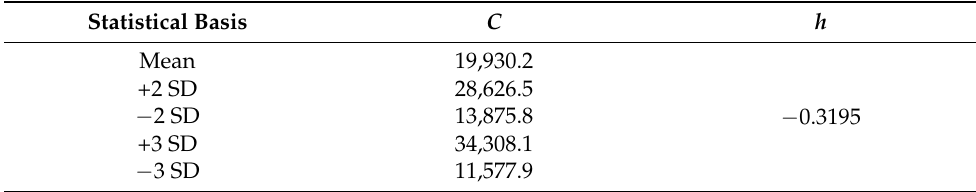
Table 1. Master S-N curve parameters according to ASME BPVC Sec VIII Div 2 [43]. Statistical